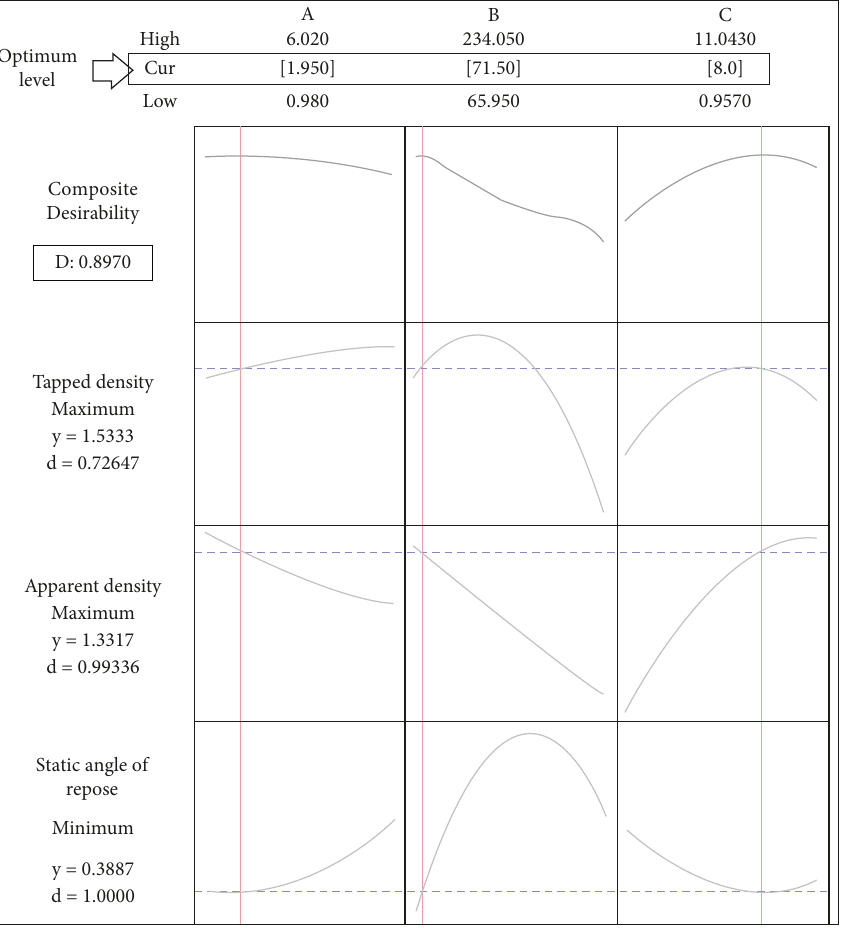
Figure 9: Composite desirability plot based on multiple